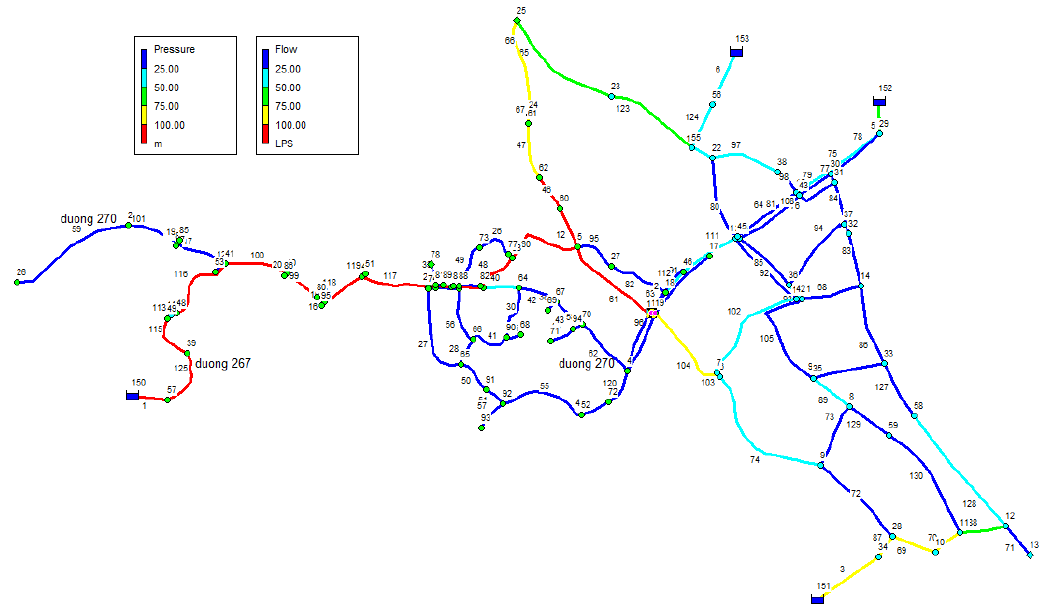
Figure 9. Water distribution system in Thainguyen, Vietnam.